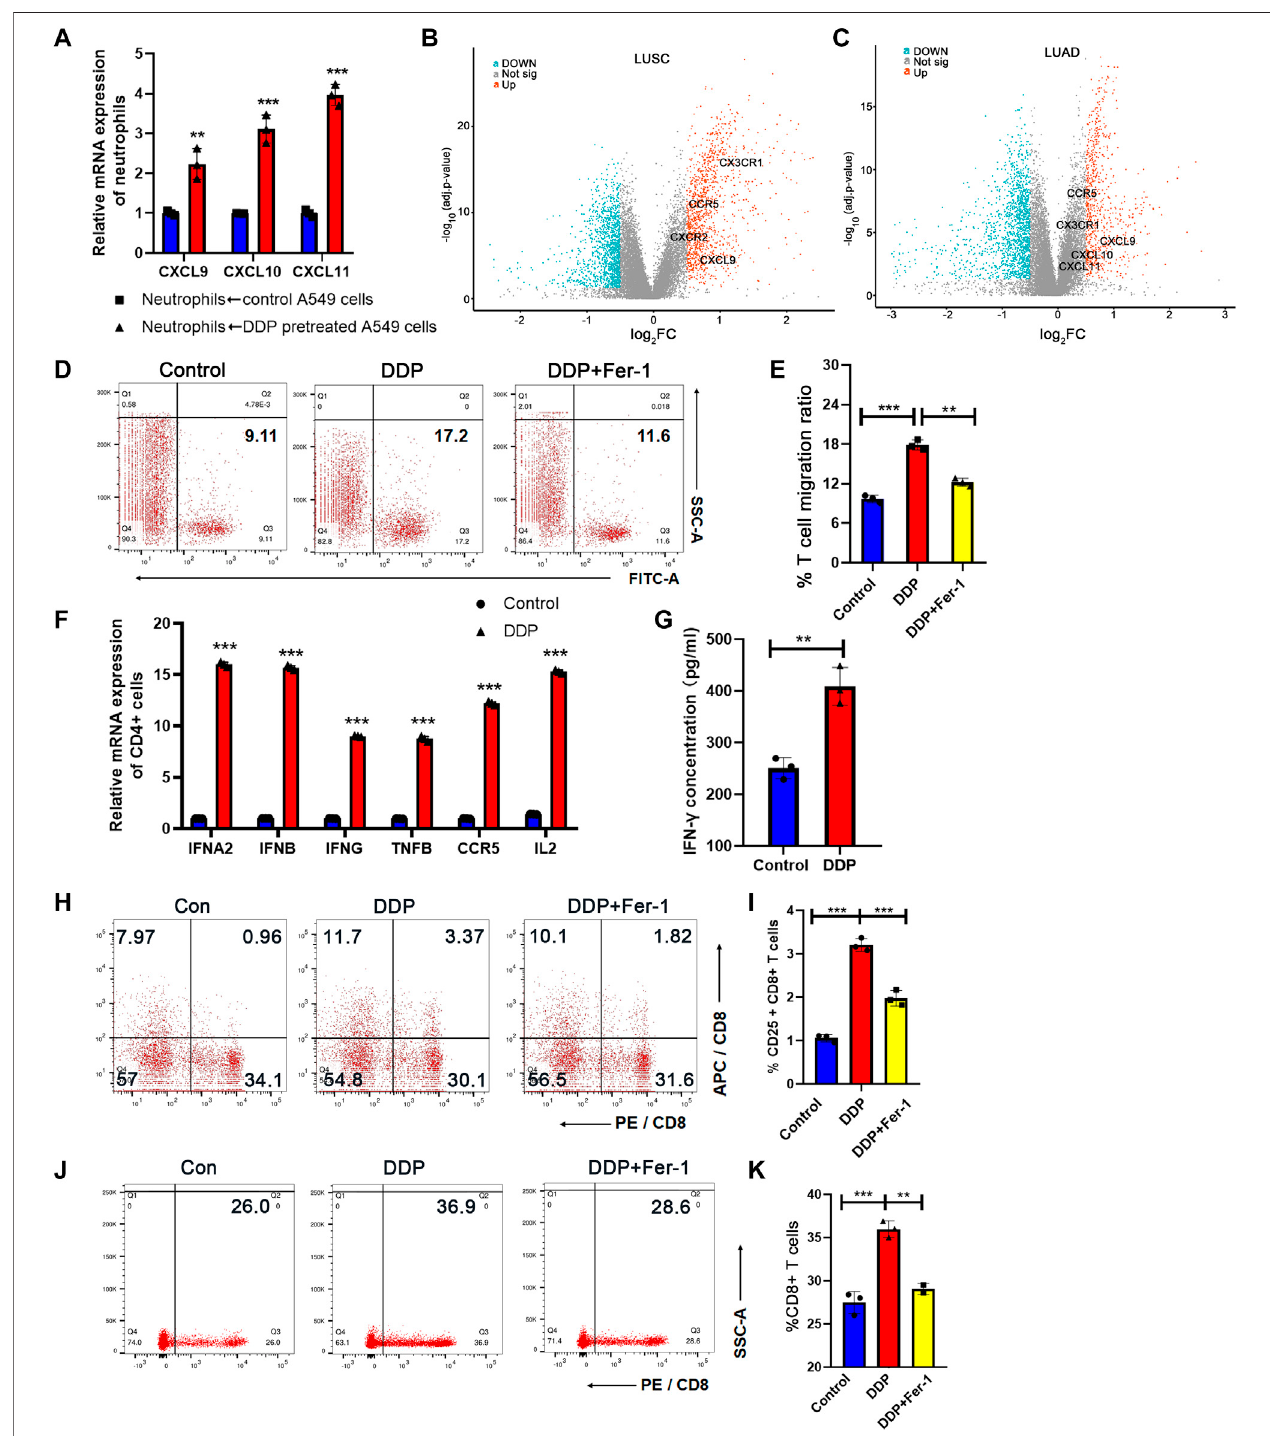
FIGURE4| N1-polarizedneutrophilsinducedbytumorferroptosispromotedT-cellin fi ltrationandTh1differentiation. (A) CXCL9,CXCL10,andCXCL11mRNAexpressionlevelsof neutrophilsincreaseafterbeingco-culturedwithDDP-pretreatedA549cells,asmeasuredbyRT-qPCR. (B) and (C) Volcanoplotbetweenhigh-andlow-ferroscoregroupsinLUSC (B) andLUAD (C) cohorts.ChemokinesforT-cellin fi ltrationwashighlightedintheplot. (D) T-cellmigrationratiomeasuredby fl owcytometryafterbeingco-culturedinthetranswellsystemwith neutrophils. The neutrophils were activated by A549 cells, pretreated with DDP or rescued by ferrostatin-1. (E) Quanti fi cation of data in (D) . (F) Markers of Th1 subtypes of CD4- positive T cells were determined by RT-qPCR. The CD4-positive T cells were co-cultured with neutrophils, which are making contact with cisplatin-pretreated A549 cells or ferrostatin- 1 – rescuedA549cells. (G) IFN- γ concentrationofCD4-positiveT-cellculturemediumincreasedafterbeingco-culturedwithneutrophilsinthetranswellsystem,measuredbyELISAassay. Theneutrophilsarecontactedwithcisplatin-pretreatedA549cellsorcontrolledA549cells.Bargraphsrepresentthemean±SDofindicatedsamples. (H) CD8 + T-cellactivationmeasured by fl ow cytometry after being co-cultured by N1 neutrophils or control neutrophils. (I) Quanti fi cation of data in (H) . (J) The proportion of CD8 T cells in the migrated lymphocytes was measured by fl ow cytometry. (K) Quanti fi cation of data in (J) . p p < 0.05, pp p < 0.01, ppp p < 0.001. Frontiers in Pharmacology |